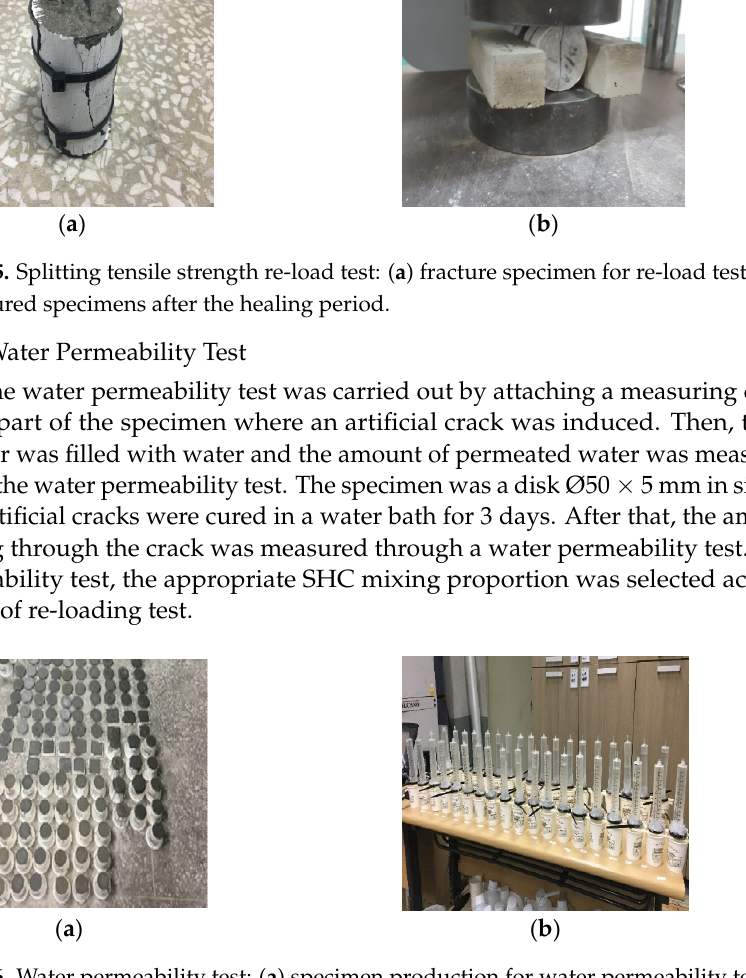
( b ) Figure 8. Observation of crack: ( a ) marking of crack area in disc specimens, ( b ) observation of cracks in disc specimens using a microscope. The small plate-shaped mold used for crack monitoring was made by hand using 3D printing. Specimens with artificial cracks were cured in a water bath for 3 days. After that, the crack surface of the specimen was monitored. The crack surface was observed at 3 levels (850, 600, and 300 μ m) of SHC which showed a large healing effect through the permeability test.